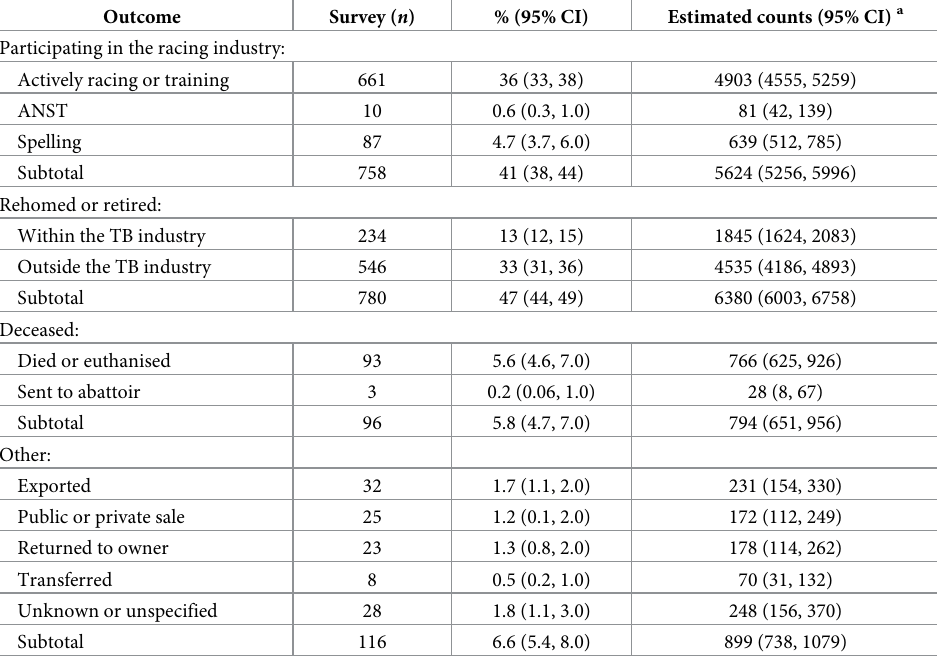
Table 7. Extrapolation of survey results to 13,696 Thoroughbred racehorses classified as inactive from the source population in the 2017–2018 Australian racing season. Outcome Survey ( n ) % (95% CI) Estimated counts (95% CI)